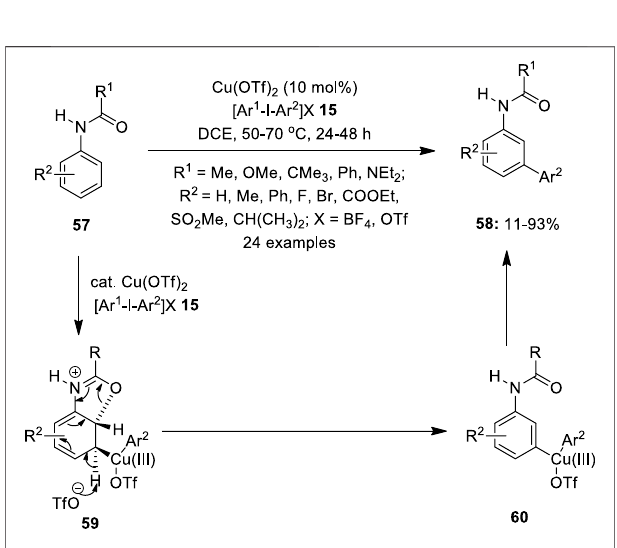
FIGURE 8 | Cu(II)-catalyzed selective meta arylation of amides 57 using iodonium salts 15 as an arylating agent.